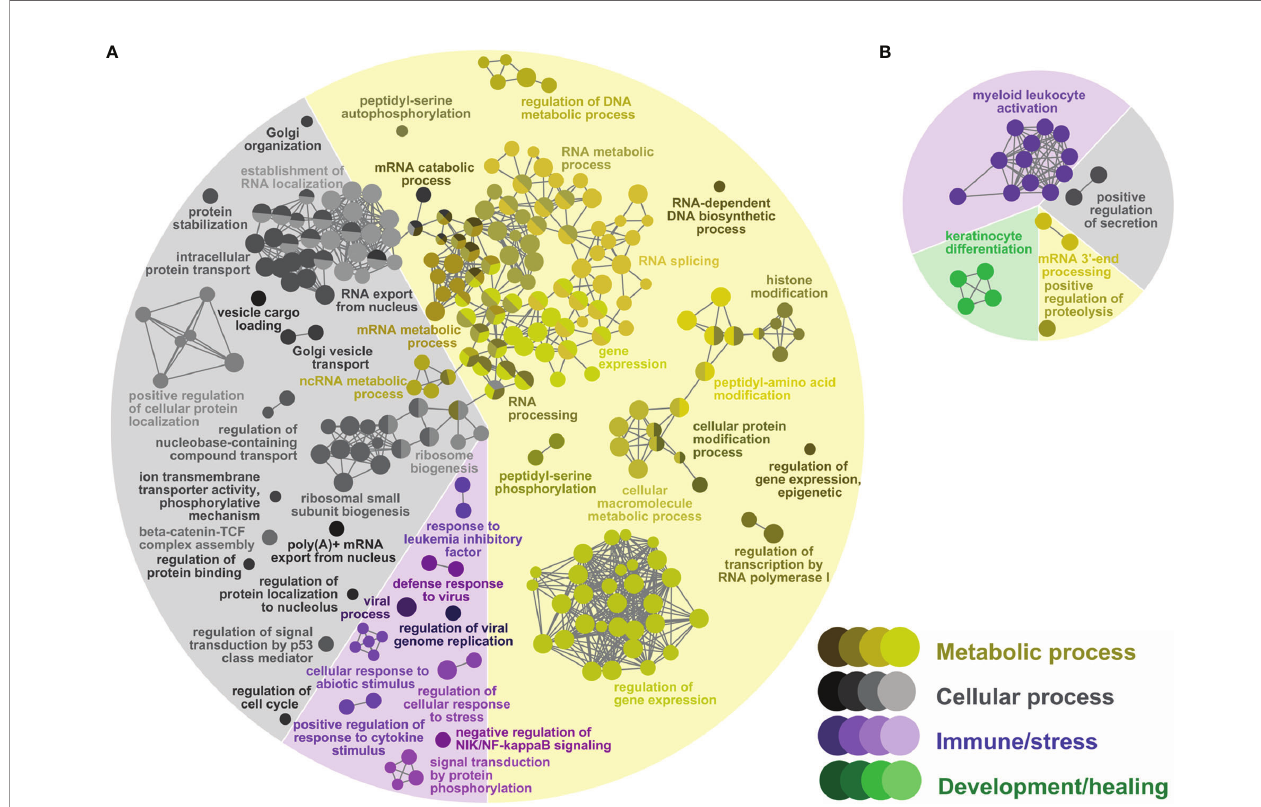
FIGURE 3 | Network GO term enrichment analysis of the differentially expressed genes (DEGs) in (A) the Lice(PBS) list, and (B) the Lice(ASAL) list. Nodes represent over-represented GO terms (right-sided hypergeometric test; adjusted p-value < 0.05). Nodes are colored according to their assigned functional theme. Highly related terms (kappa coef fi cient > 0.4) are connected with grey lines. Single GO terms (i.e., single node) and GO networks are grouped and colored by functional theme (e.g., metabolic process, immune/stress) and arranged to fi t the pie chart sectors representing the proportion of GO terms in each functional theme. Some GO groups comprised terms from different themes; in such cases, the group is colored according to the theme with the highest number of GO